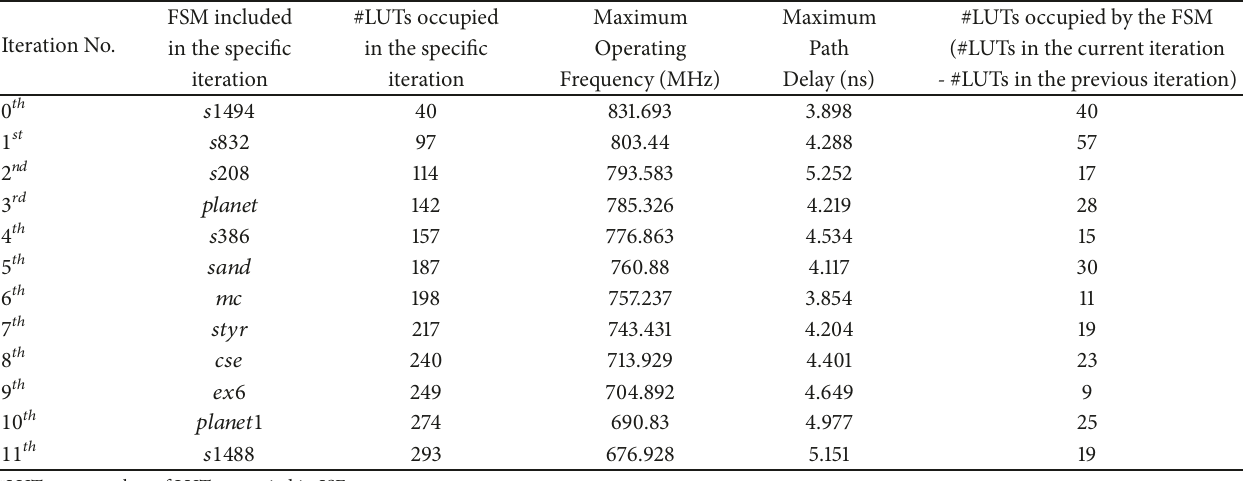
Table 9: Implementation of the Improved Reconfigurable FSMIM architecture on the Virtex-6 speed-3 device in an iterative manner. Iteration No.